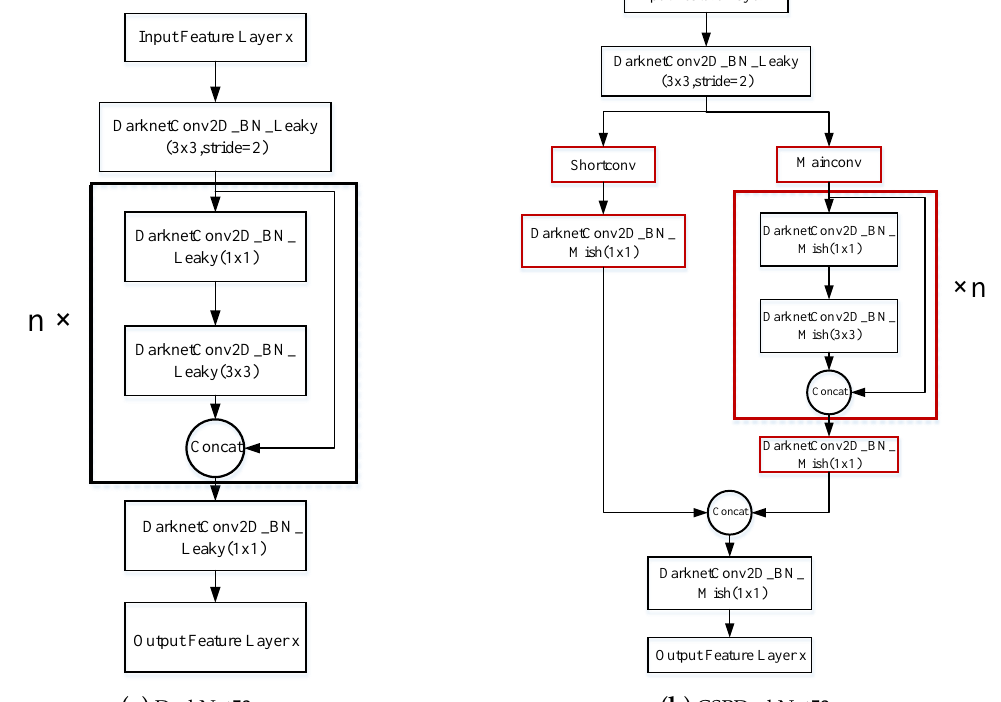
Figure 2. The network structure of DarkNet53 and